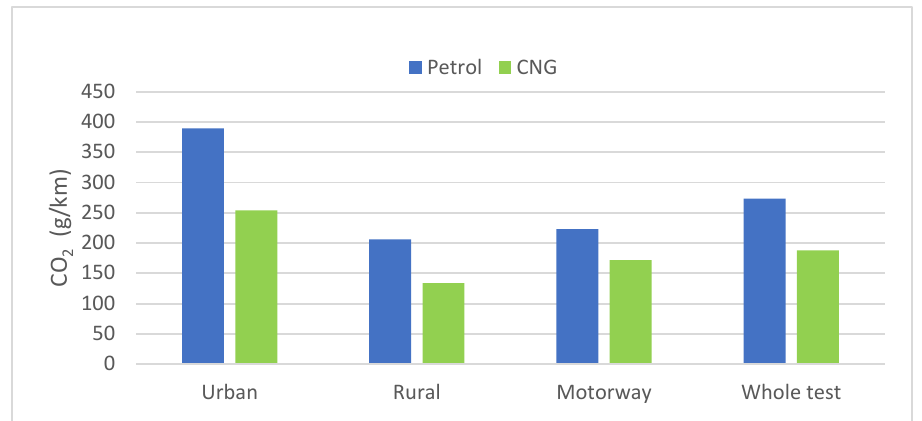
Figure 9. Average CO 2 emission for on-road test.